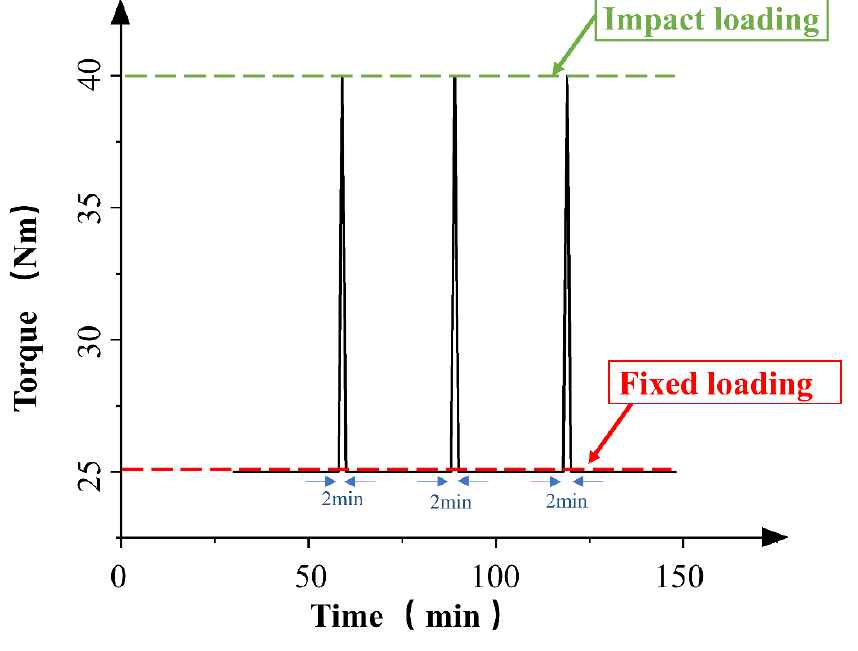
Figure 2. Impact loading mode. Table 1. Helical gear